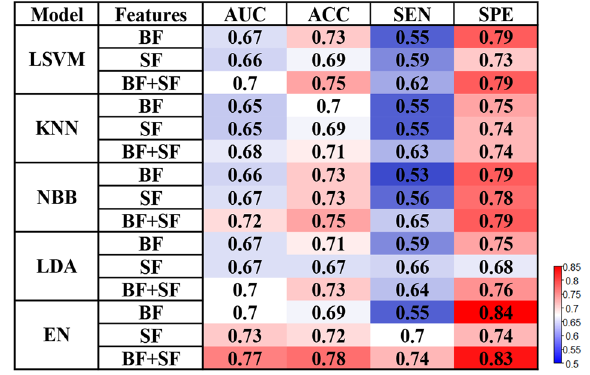
Fig. 2 Freezing of gait prediction performances with various machine learning models and